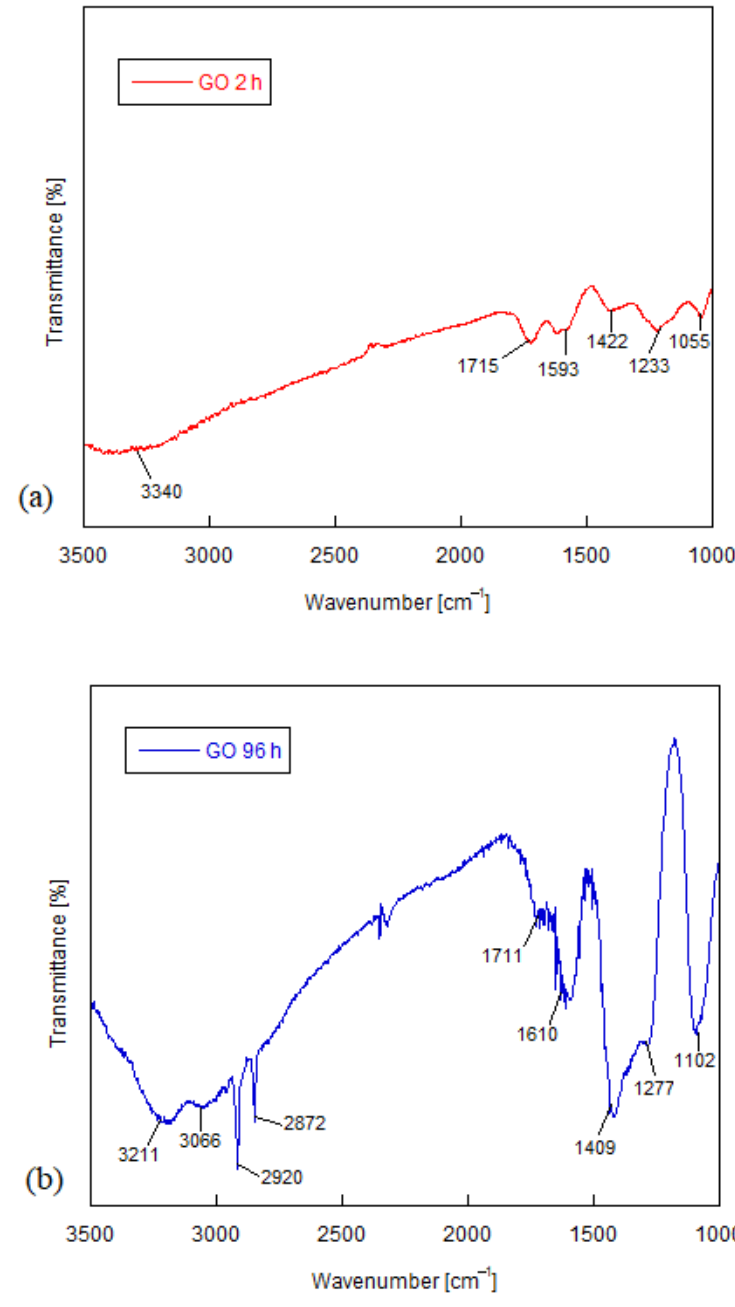
Figure 5. FTIR spectrum of GO with ( a ) 2 h ( b ) 96 h of oxidation.